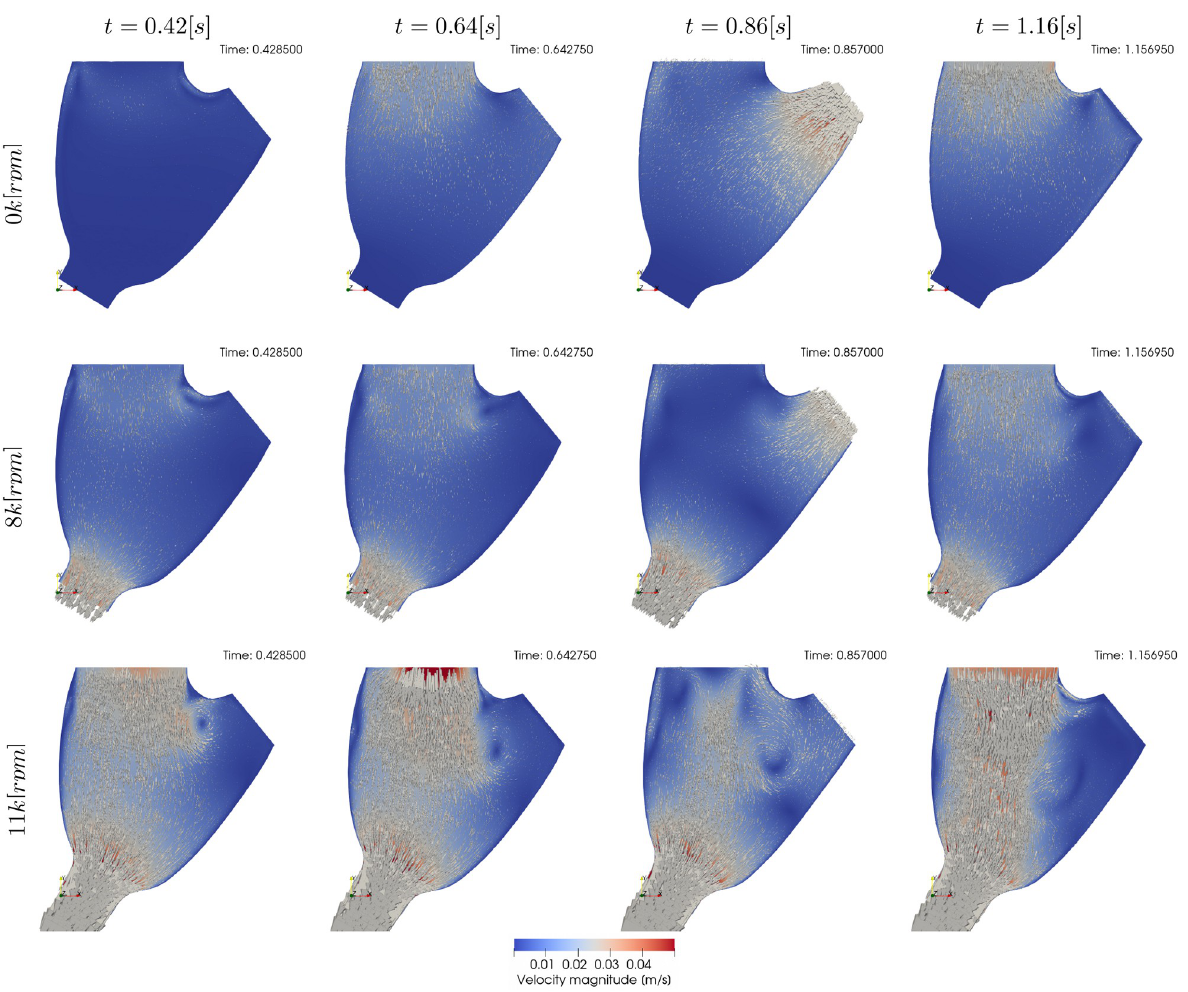
Fig 8. Qualitative surface results for the condition 17[%]@61.18[ bpm ]. Pump speed is 0 k [ rpm ], 8 k [ rpm ], and 11 k [ rpm ] in the first, second, and third rows respectively. The columns indicate different time frames in the simulation. t = 0.42[ s ] show results for the plateau previous to systole, t = 0.64[ s ] show the atrial kick, t = 0.85[ s ] show systole, and t = 1.16[ s ] shows the diastolic filling. Videos of the simulations can be found in the S1